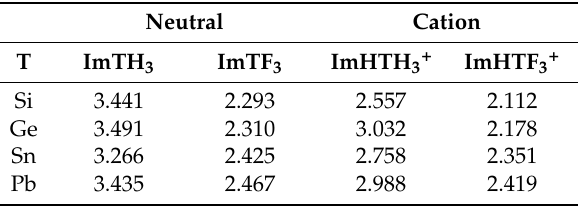
Table 2. R(T · Cl) (Å) in optimized complexes.